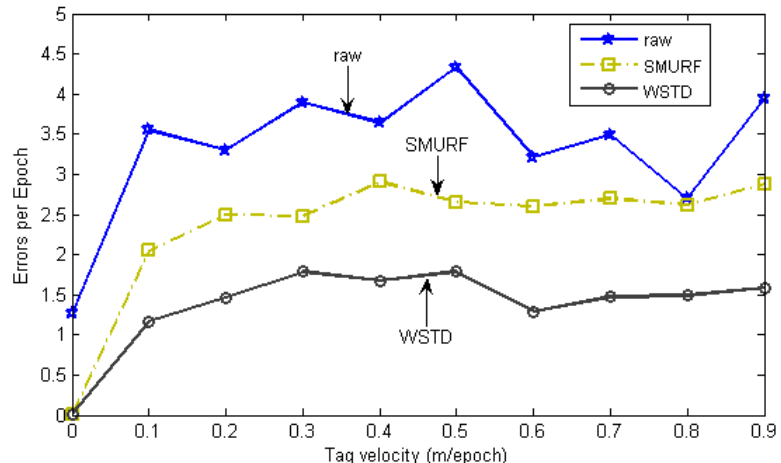
Figure 10 . Average errors per epoch as tag velocity